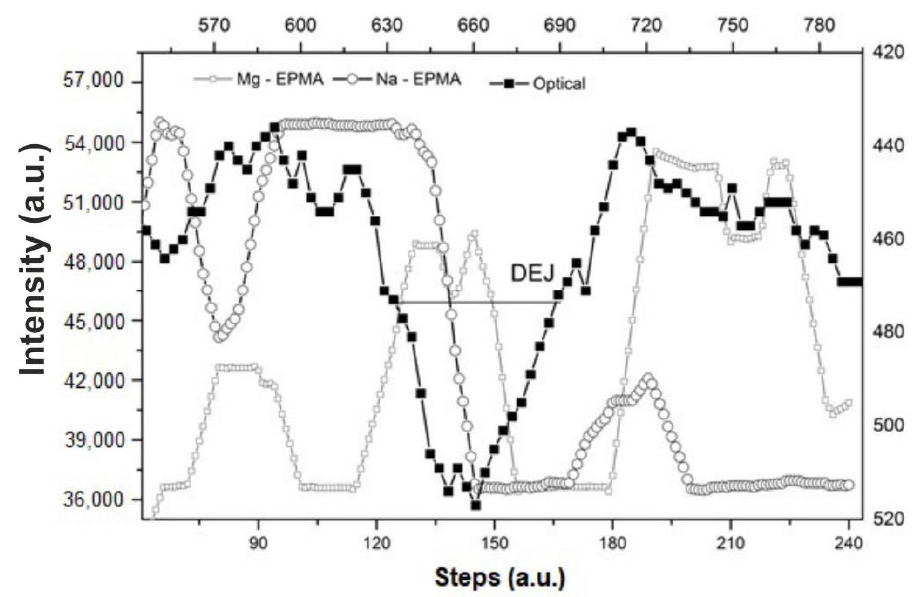
Figure 6. Distribution of Na, Mg and CO 3 2 − ions around DEJ. Enamel is on left side of the figure. Optical signal outlines the DEJ